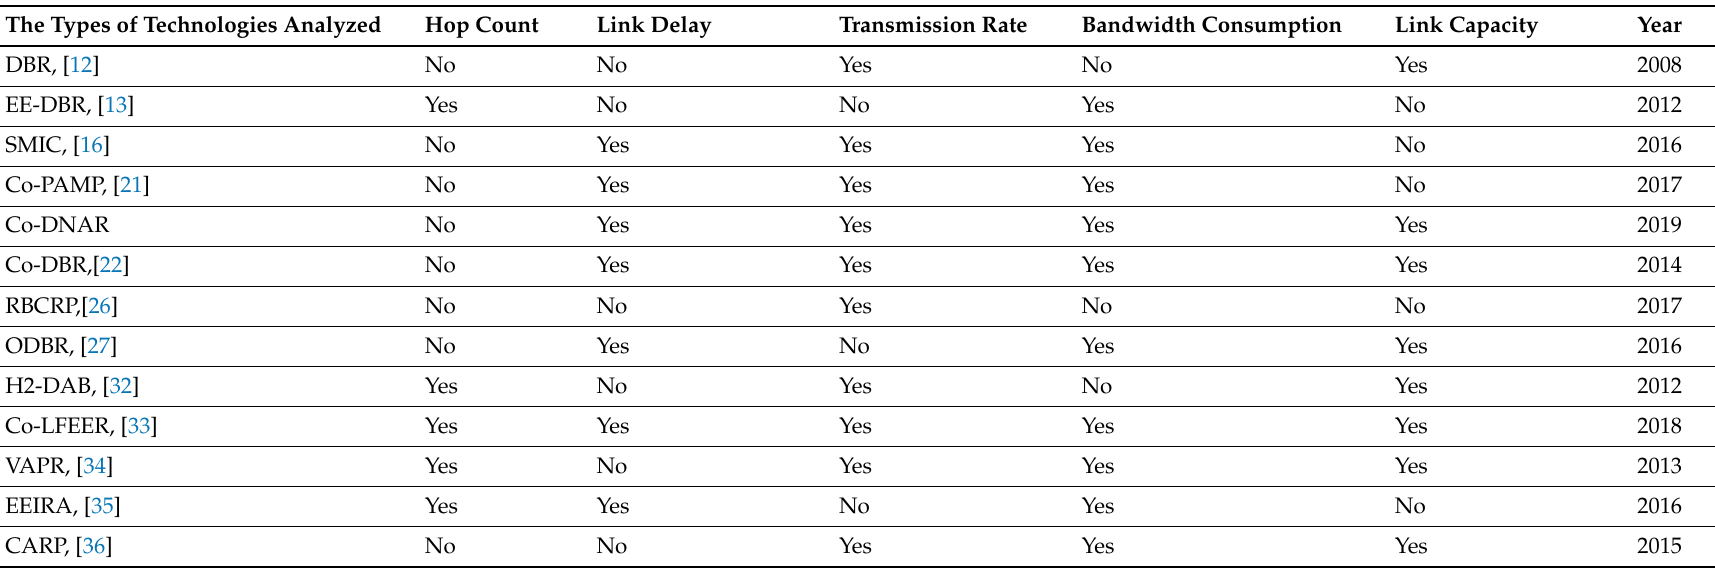
Table 1. The comparison of our contributions with existing